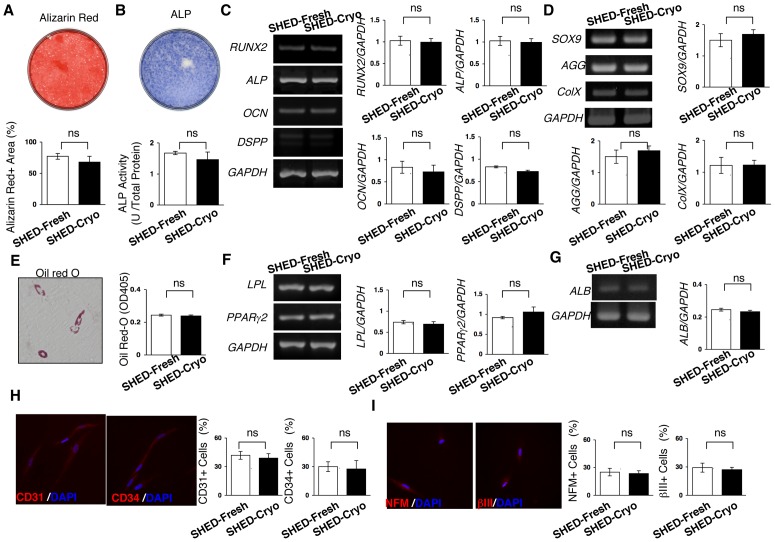
Multipotency of SHED-Cryo.(A–C) Dentinogenic/osteogenic differentiation capacity. Images of Alizarin Red staining (A) and alkaline phosphatase (ALP) activity (B) of SHED-Cryo. Comparison of Alizarin Red-positive (Alizarin Red+) area (A), ALP activity (B) and odontoblast/osteoblast-specific genes, runt-related gene 2 (RUNX2), ALP, osteocalcin (OCN), and dentin sialophosphoprotein (DSPP) (C). (D) Chondrogenic differentiation capacity. Comparison of chondrocyte-specific genes, SOX9, aggrecan (AGG) and type X collagen (ColX). (E, F) Adipogenic differentiation assay. A representative image of Oil Red-O staining and comparison of Oil Red-O accumulation (E). Comparison of adipocyte-specific genes lipoprotein lipase (LPL) and peroxisome proliferator activated receptor-gamma2 (PPARgamma2) (F). (G) Hepatogenic differentiation capacity. Comparison of hepatocyte-specific gene albumin (ALB). (H) Endothelial cell differentiation assay. Comparison of endothelial cell markers CD31 and CD34. (H) Neural cell differentiation assay. Comparison of neural cell markers neurofilament M (NFM) and tubulin betaIII (betaIII). A–I: n = 5 for all group. ns: no significance. The graph bars represent mean±SD.